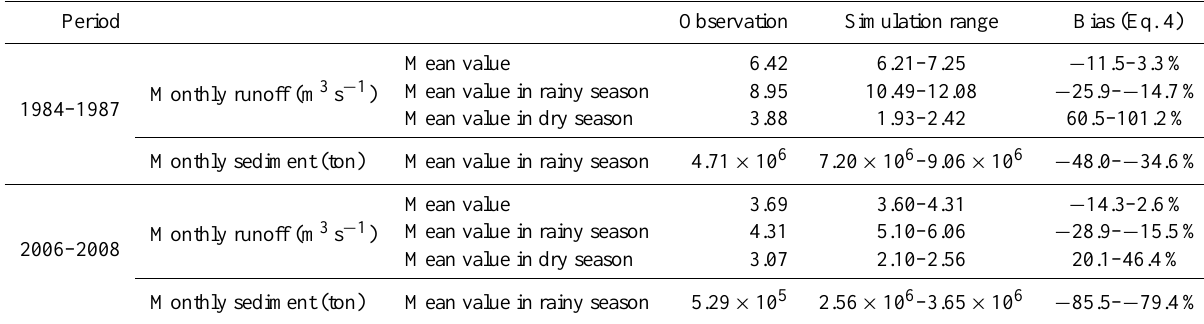
Table 5. The mean observed and simulated values of 1984–1987 and 2006–2008. Period Observation Simulation range Bias (Eq.